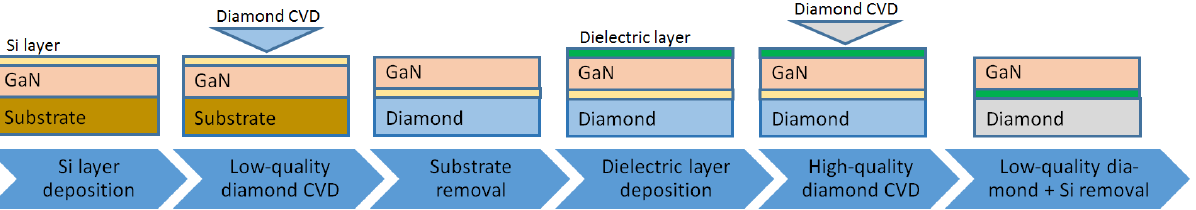
Figure 20. Fabrication of GaN-on-diamond wafers by dual-sided diamond deposition.